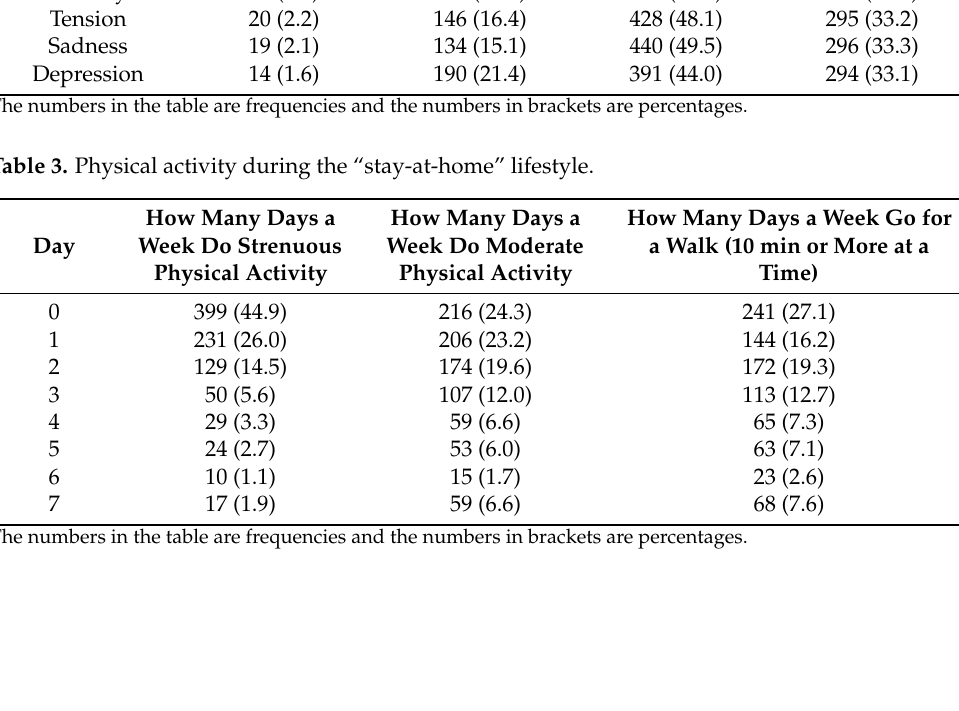
Table 2. Overeating for psychological factors. Overeating Because of